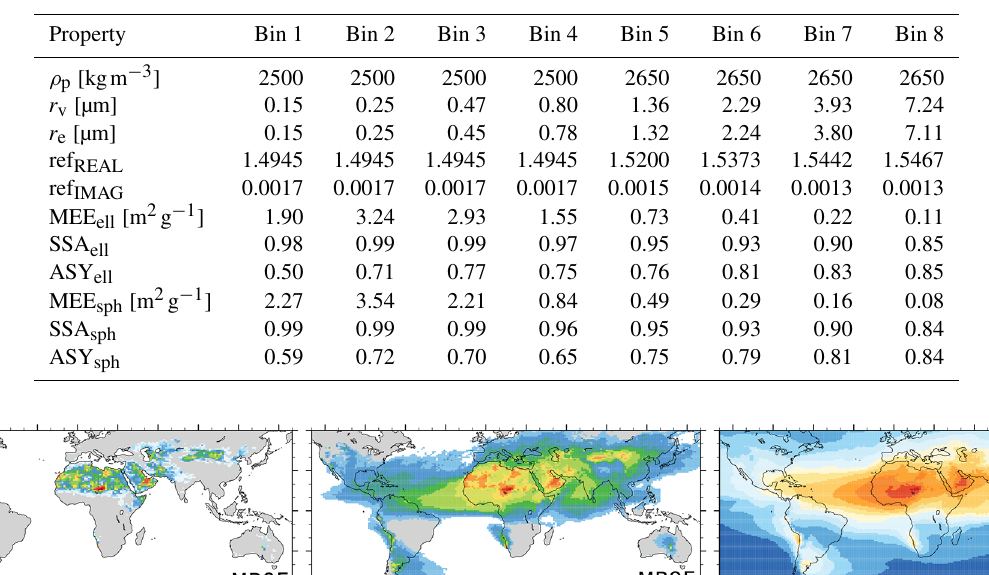
Table 6. Physical and optical particle properties available in MONARCH for eight particle-size bins: equivalent volume radius ( r v ), effective radius ( r e ), density ( ρ p ), real and imaginary parts of the refractive index (ref REAL , ref IMAG ), mass-extinction efficiency (MEE, [m 2 g − 1 ]), single-scattering albedo (SSA), and asymmetry factor (ASY). The optical properties are for a wavelength of 550nm and MEE, SSA, and ASY are given assuming ellipsoidal (index ell) or spherical (index sph) particle shape. The diameter ranges of each bin are given in Sect. 3.